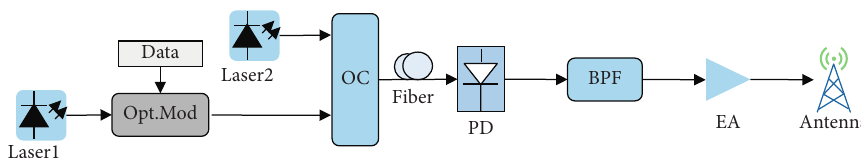
Figure 4: Optical heterodyne scheme structure diagram. OC, optical